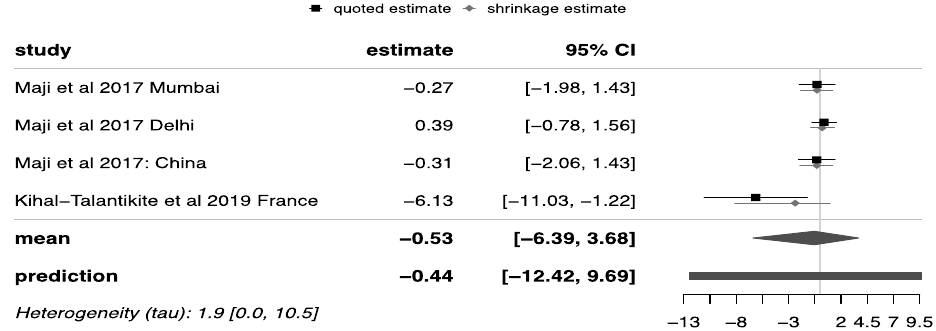
Figure 5. Forest plot PM10. The values of the forest plots indicate the log mortality rate mapped to their corresponding normal distribution